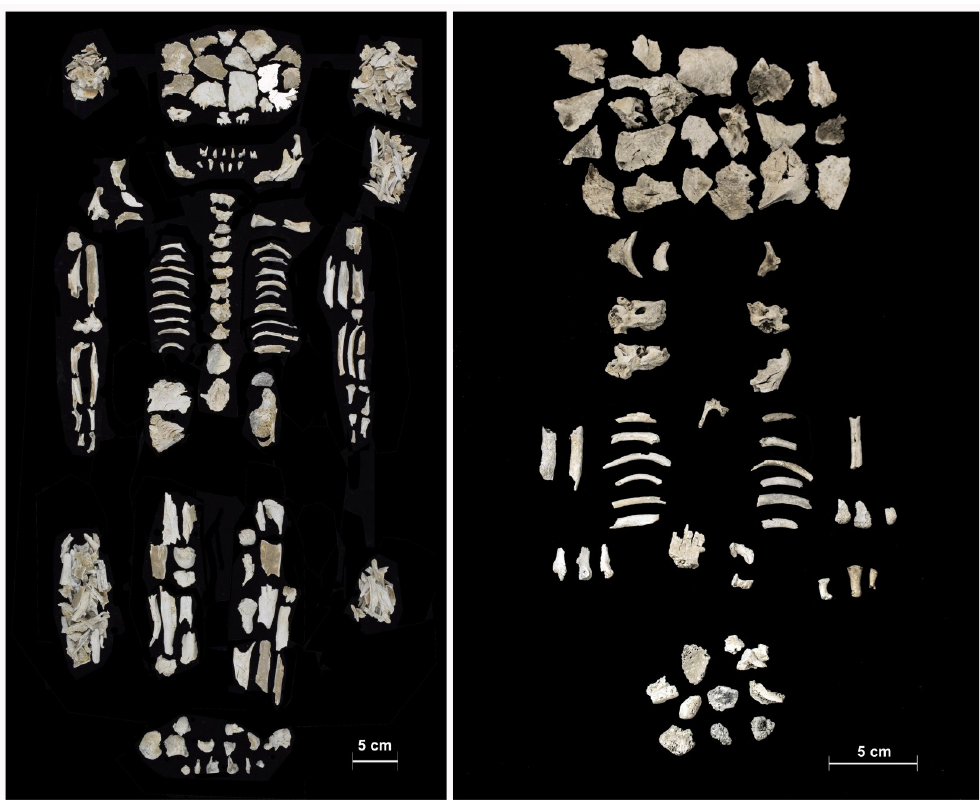
Fig 4. Left: Bone assemblage from burial n. 241a (adult female individual). Right: Bones attributable to both foetuses (n. 241b and